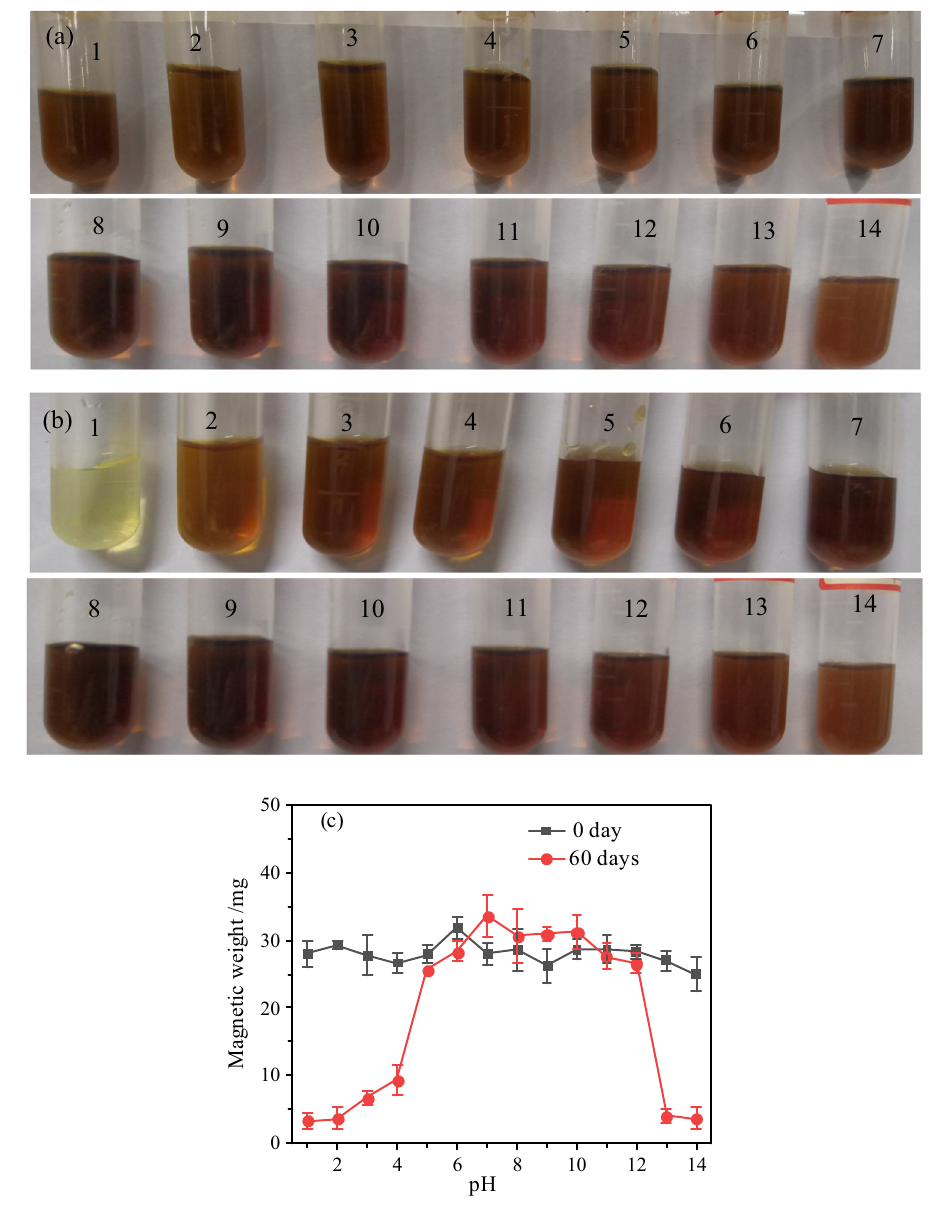
Figure 5: Stability change in Fe 3 O 4 @DDT - PMAA MF in di ff erent pH environments for di ff erent time, ( a ) photos for 0 day; ( b ) photos for 60 days; and ( c ) magnetic gain in 60 days with 40